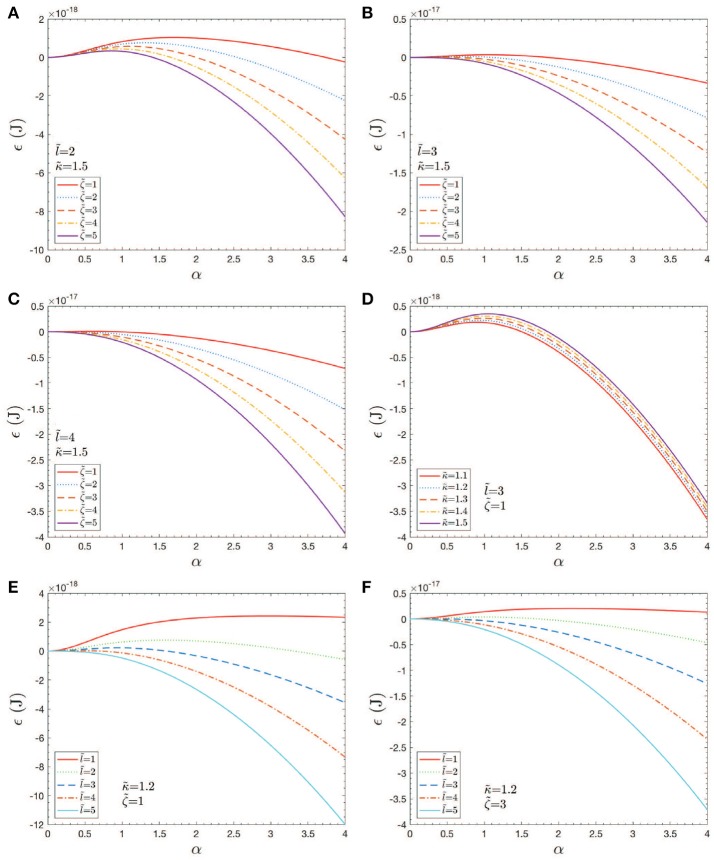
Case studies of total energy, ϵ vs. h = αℓ0. Note that an ℓ0=40nm (ℓ~=4) would correspond to an initial skeletal/membrane separation covering about one JC unit. The parameters in the cases shown in (A–F) are listed within the figure.